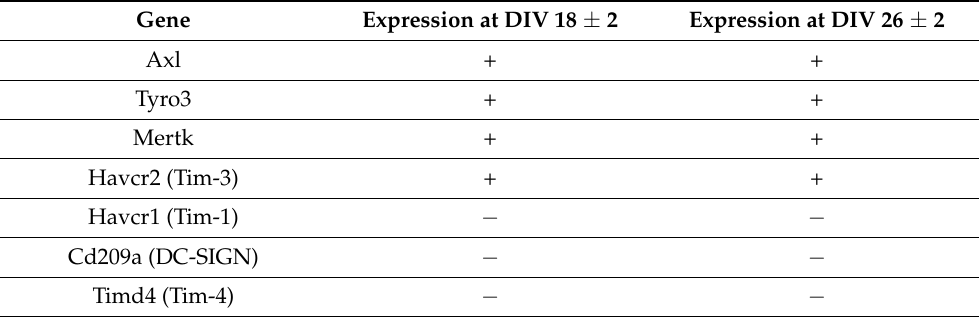
Figure A1. Representative image of analysis for receptor expression. Endpoint PCR products of cDNA from immature (DIV 18 ± 1) and mature (DIV 28) cultures are visualized by ethidium bromide after agarose gel electrophoreses. 18S is used as a reference gene. Controls: -RT did not contain the reverse transcriptase during cDNA generation; spleen included as reference for receptors known to be expressed by adaptive immune cells; water did not contain cDNA. Table A2. Expression of putative ZIKV receptors in CNS myelinating cultures.